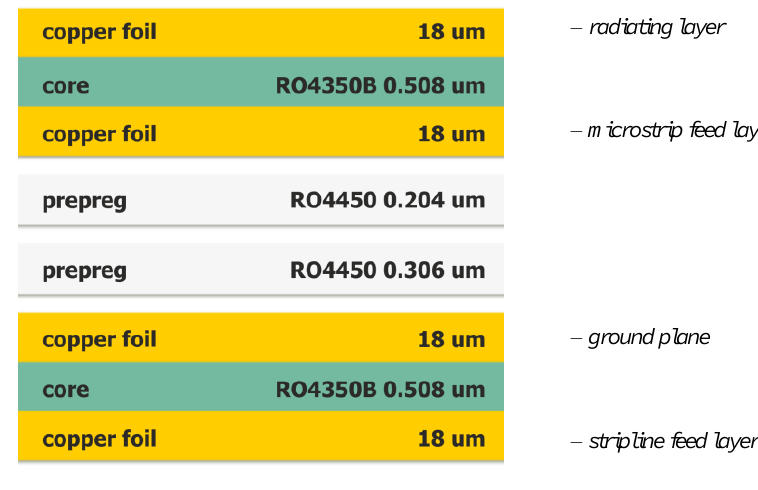
Fig. 1. Layout and side view of the emitter.